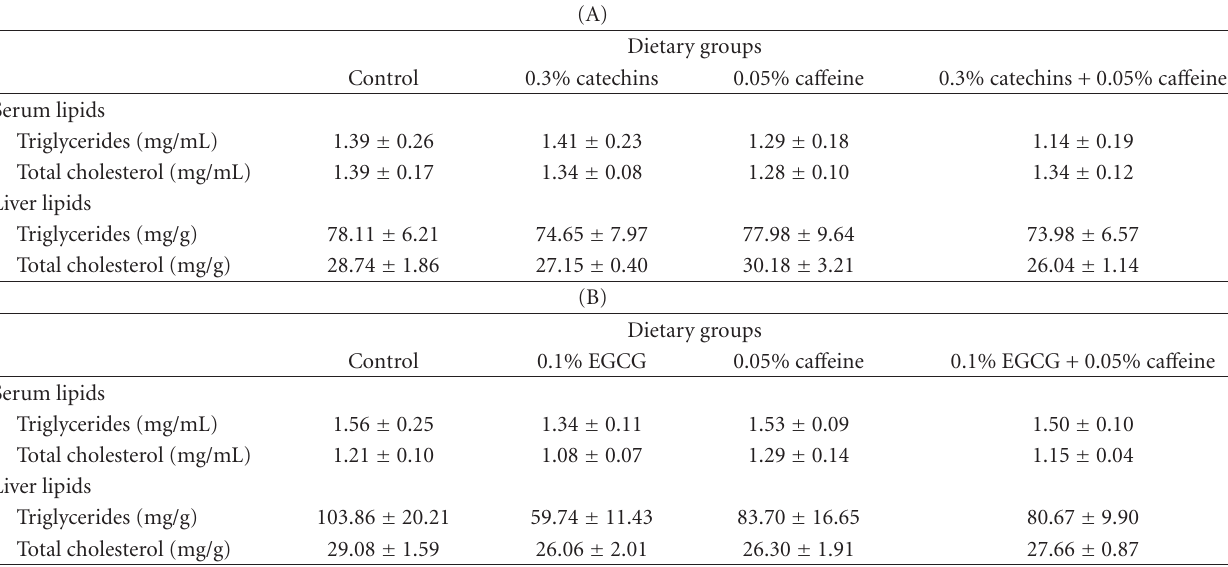
Table 2: E ff ects of catechins, EGCG, and ca ff eine on lipid levels in serum and liver in mice.